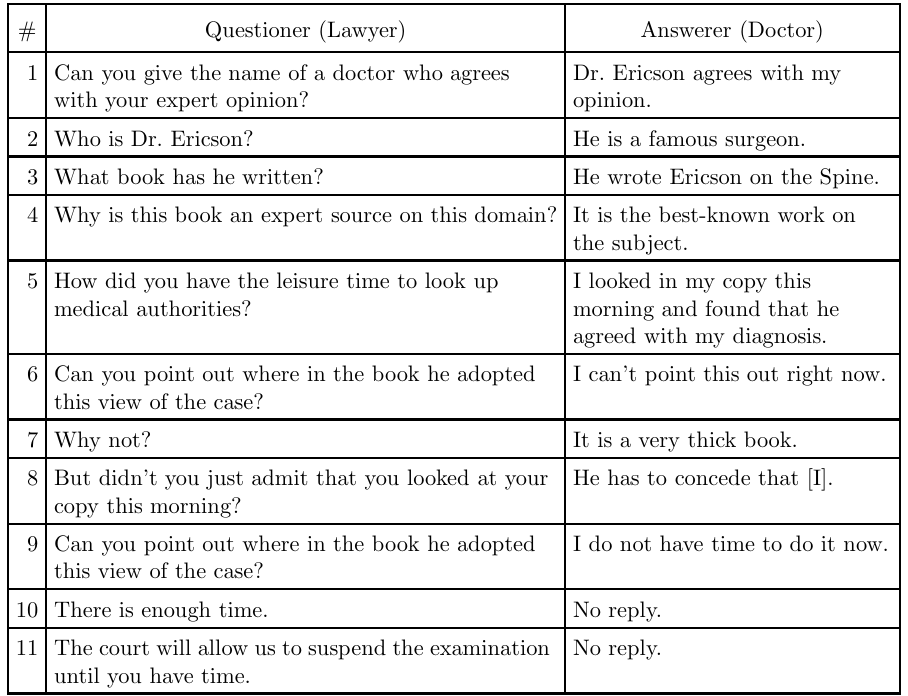
Dialogue for the Expert Opinion